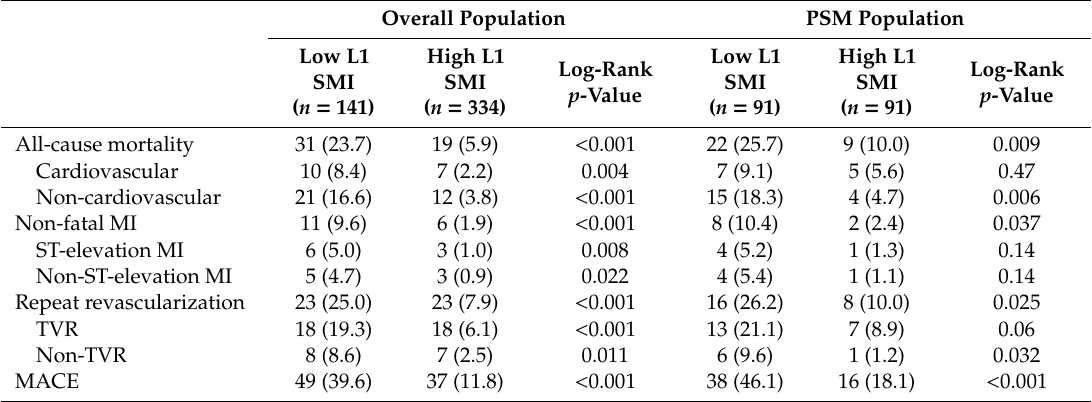
Table 2. Kaplan–Meier survival analysis of 3-year clinical